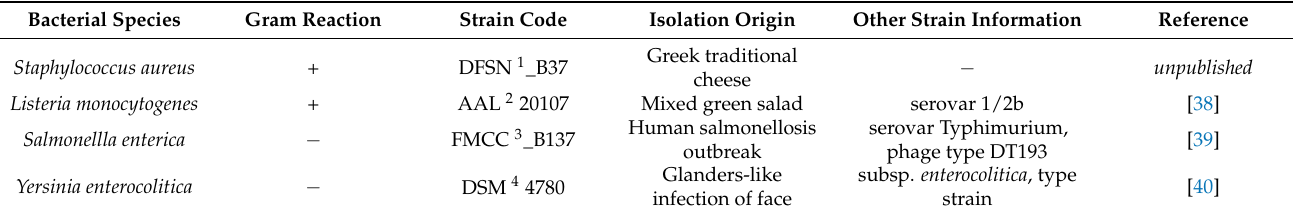
Table 1. Bacterial strains used in this study and relevant